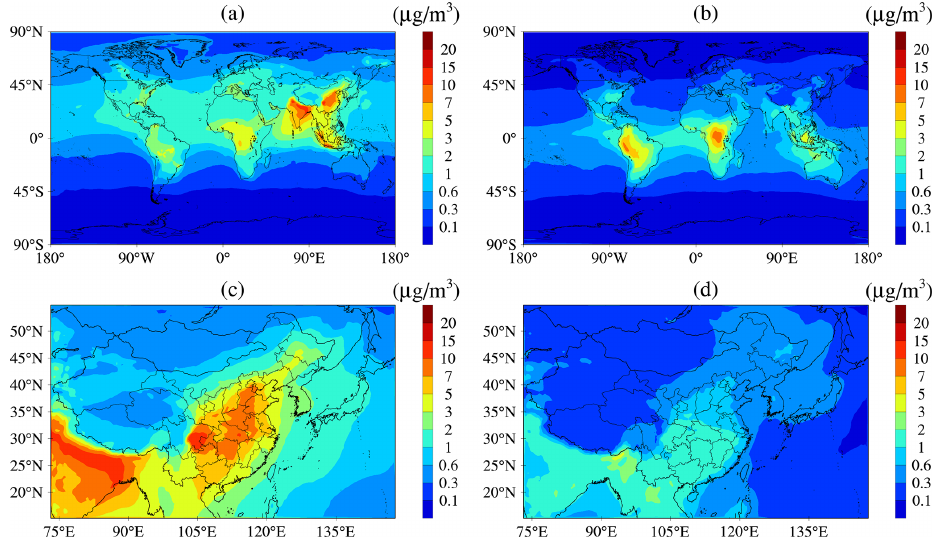
Figure 5. Surface layer horizontal spatial distributions of ASOA concentrations (a, c) and BSOA concentrations (b, d) over the first do- main (a, b) and second domain (c, d)